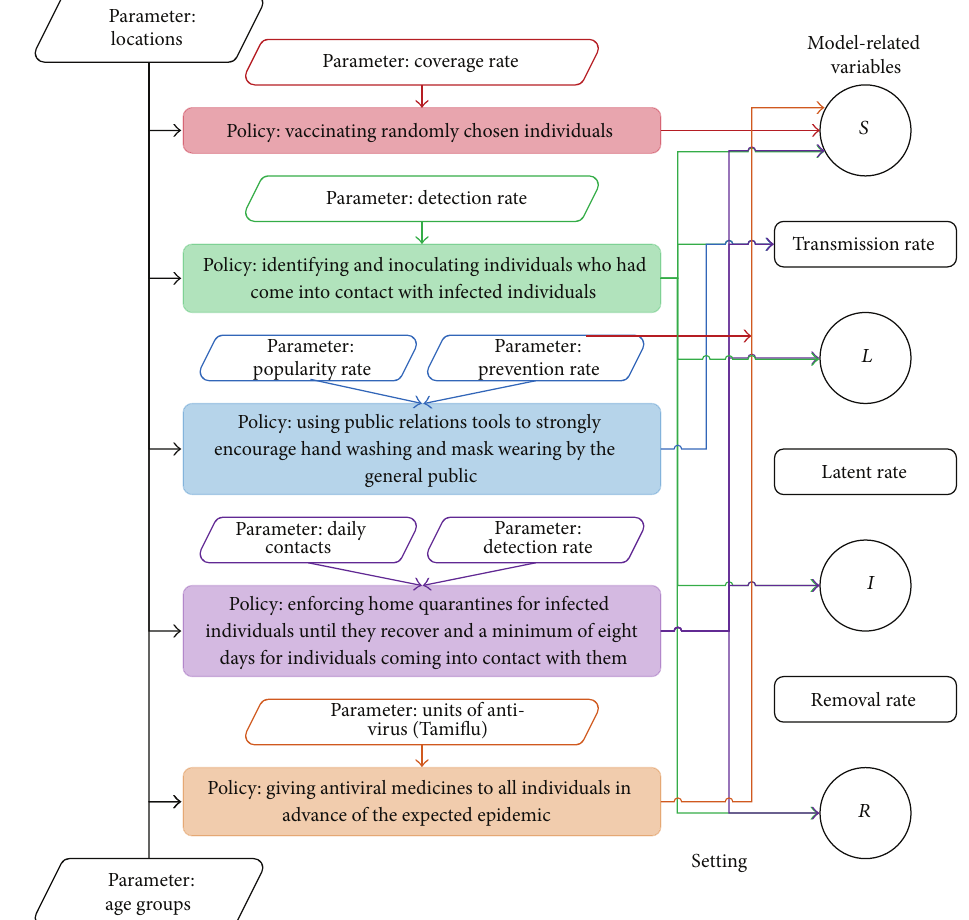
Figure 14: Relationships of five intervention policies and the FLUed-related variables.